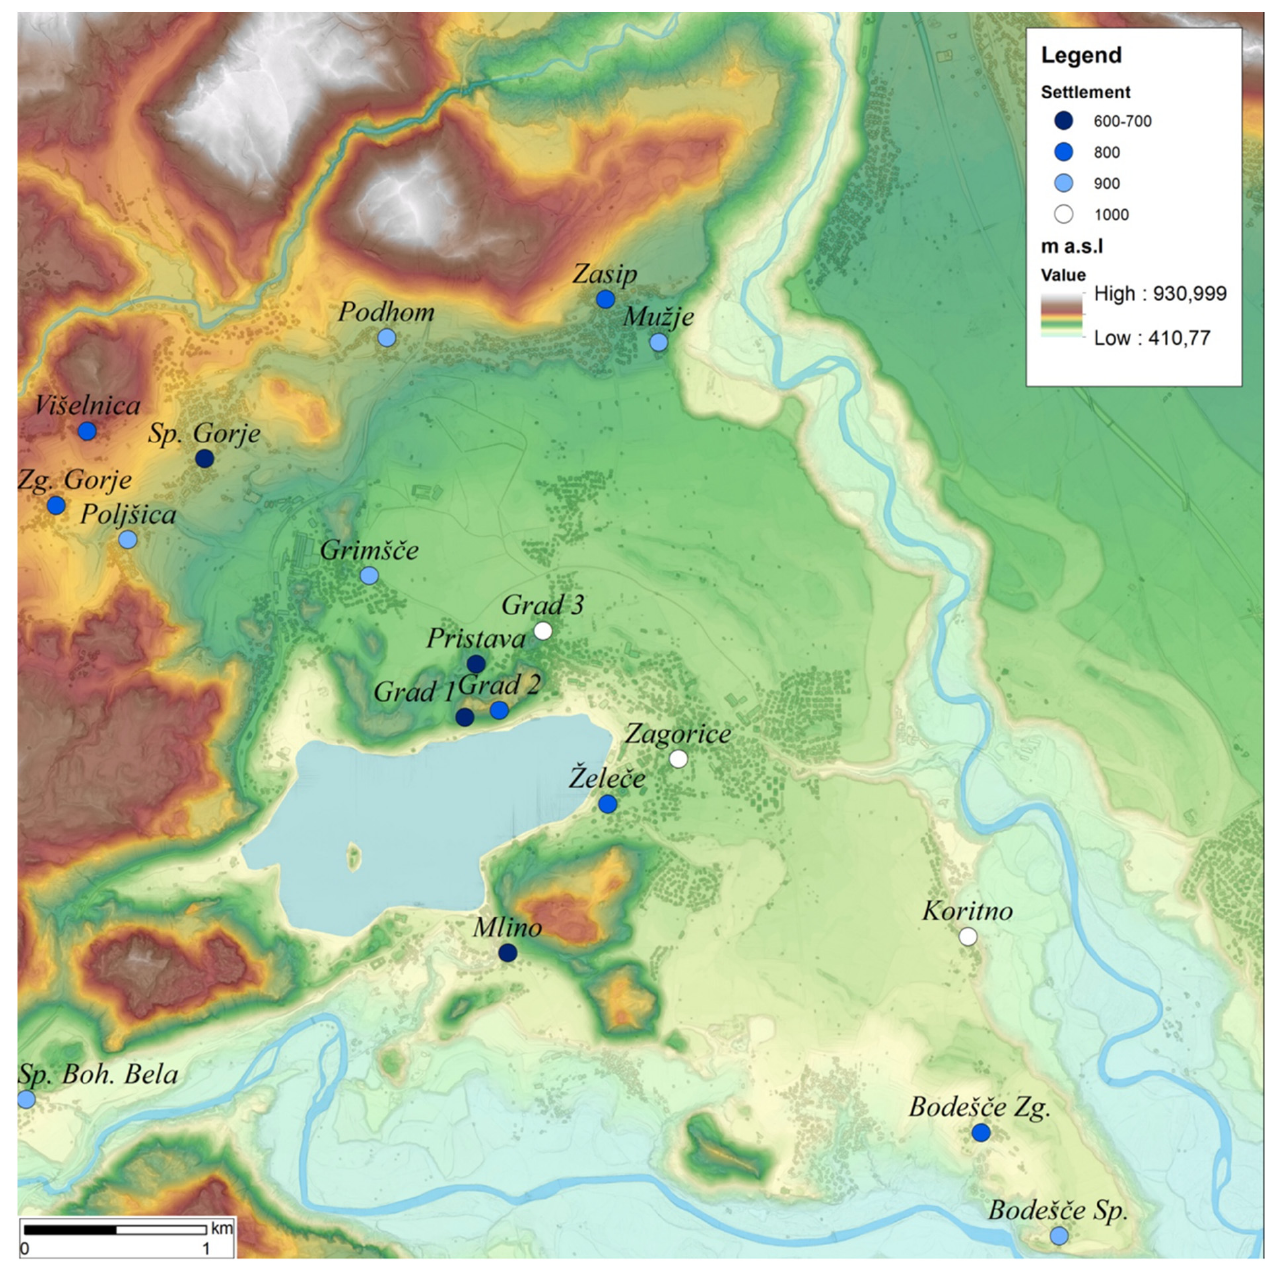
Figure A5. Bled microregion (decimal longitude and latitude coordinates of the map centre: 14.1139; 46.3752), visualisation created for visual geomorphological analysis (hypsometric tinting of high-resolution DEM, transparently (60%) superim- posed over a hillshaded surface). The highest elevation zone is white, brown represents the mountainous plateau, a darker green for the upper slopes, and light green for the verdant valleys. EMS are represented with points. North at the top.